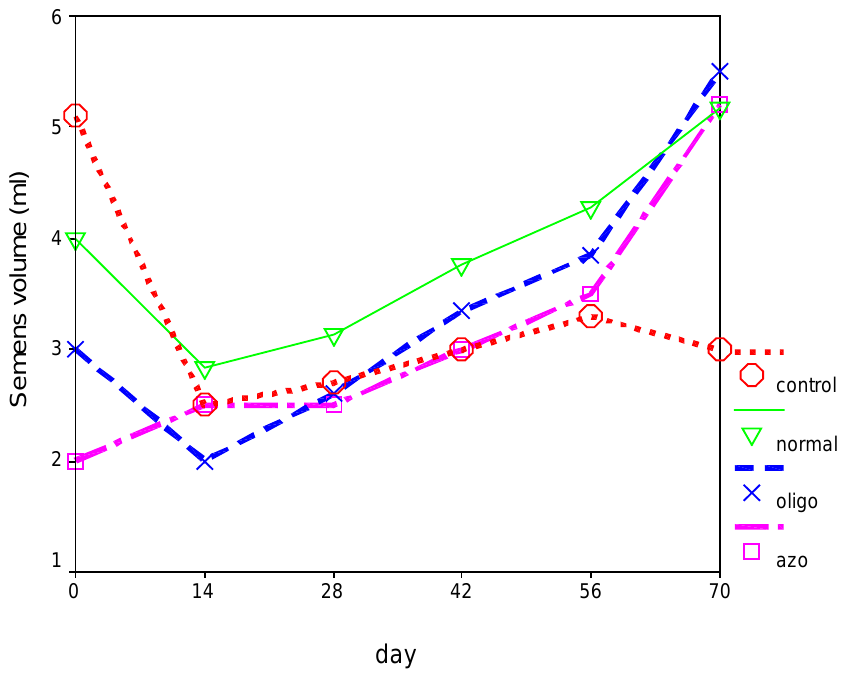
FIGURE 1. Effect of C. populnea aqueous extract on semen volume.